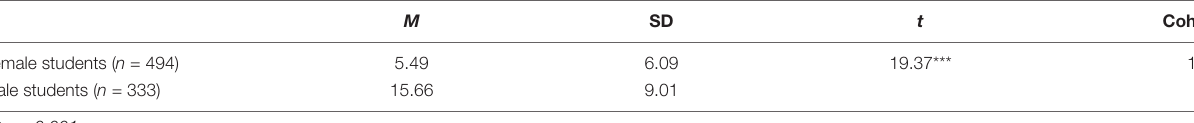
TABLE 2 | Difference between male and female students engaging in physical activity.